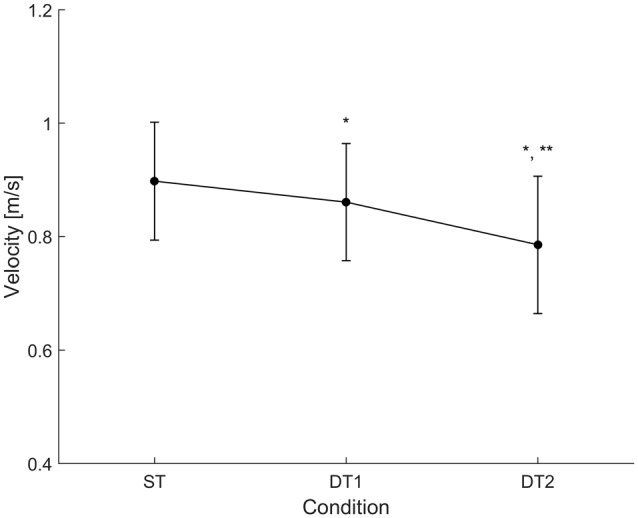
Condition-by-condition gait velocity. A condition-by-condition population average (N = 14) profile with standard deviation error bars. Average gait velocity decreases in the two dual-task conditions with respect to the single-task condition. Statistically significant paired-samples t-test corrected for multiple comparisons (Bonferroni, ×3) are highlighted with *(ST vs. DTi with i = 1, 2) and/or **(DT1 vs. DT2). Detailed results are reported in Table 1.